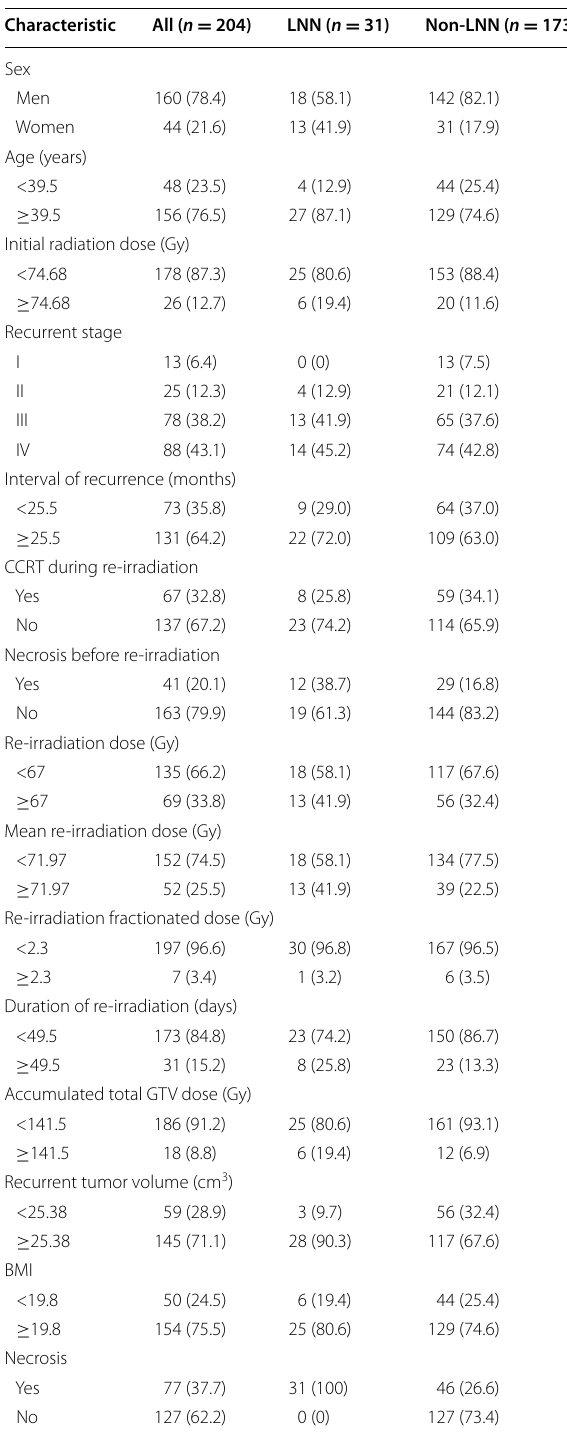
Table 1 Characteristics of 204 patients with locally recur- rent nasopharyngeal